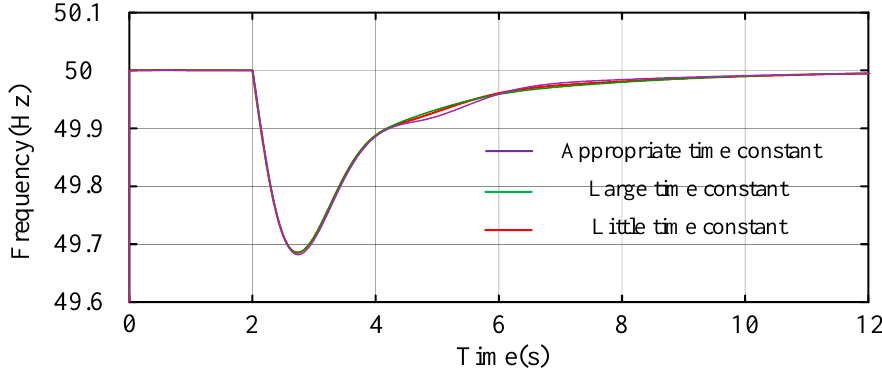
Figure 12. System frequency regulation result with different time constants of the delay link.